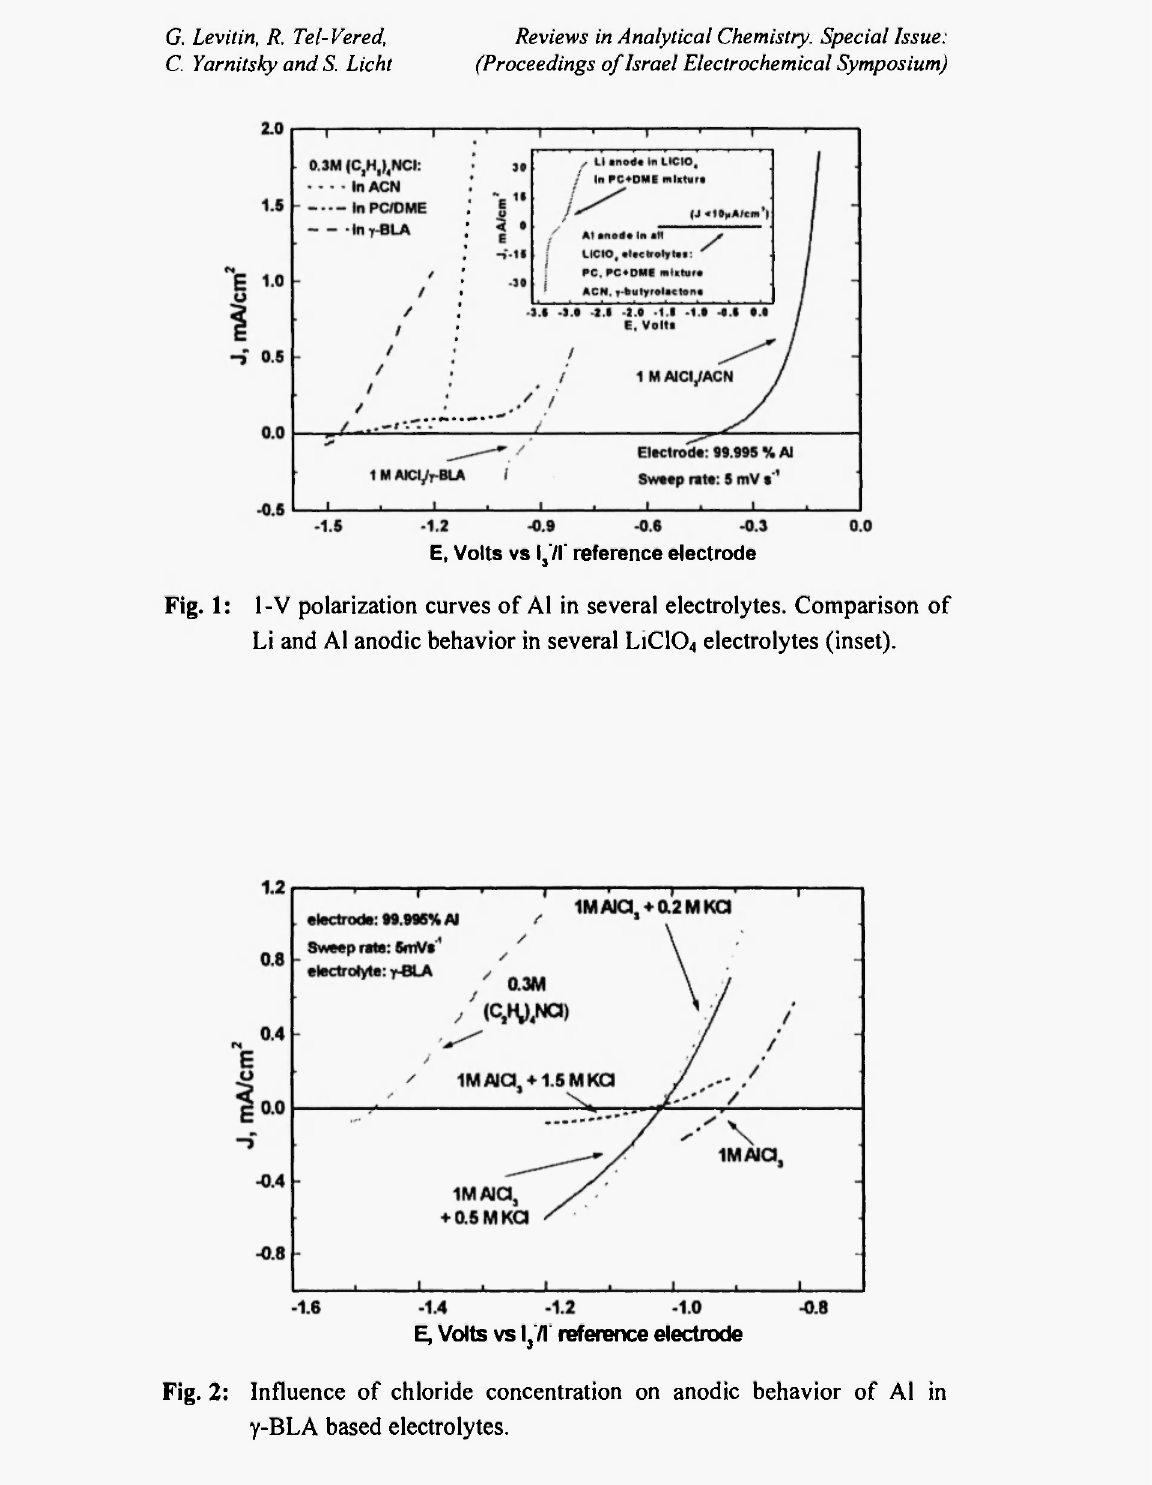
Fig. 2: Influence of chloride concentration on anodic behavior of Al in γ-BLA based